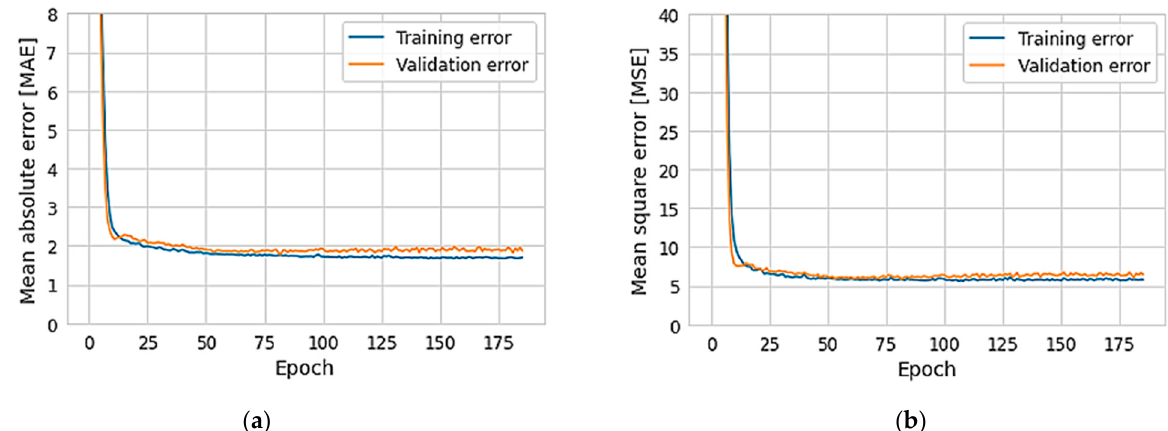
Figure 14. ANN application prediction errors, ( a ) mean absolute error (MAE) , ( b ) mean squared error (MSE) .